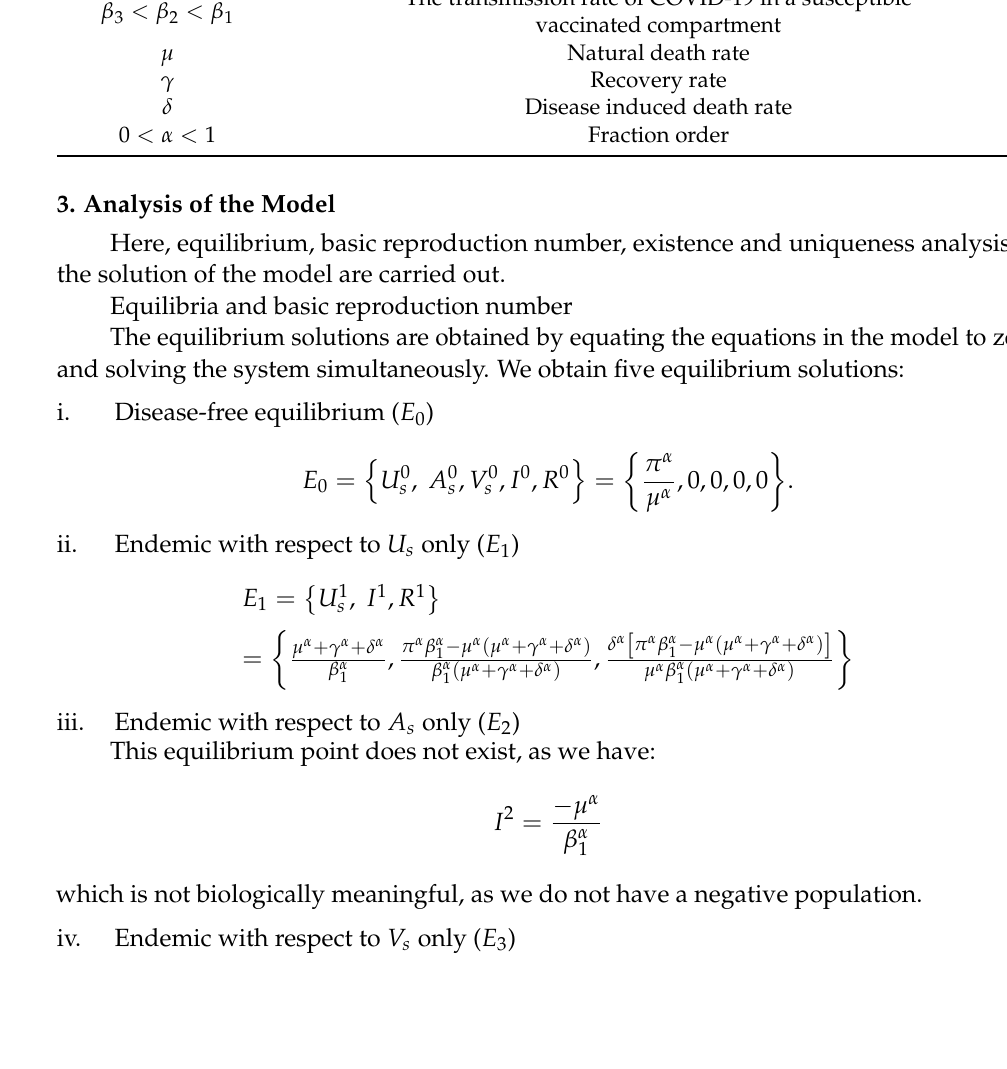
Table 1. Meaning of Parameters. Parameter Meaning π Recruitment rate β 1 The transmission rate of COVID-19 in a susceptible unaware compartment β 2 < β 1 The transmission rate of COVID-19 in a susceptible aware compartment The transmission rate of COVID-19 in a susceptible vaccinated compartment Natural death